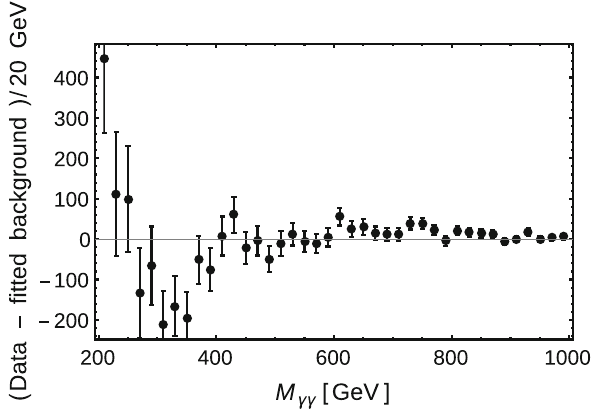
Fig. 6 Thedifferencebetweenthebinnedeventswithselectioncriteria C 2 and their smooth fit by the ATLAS fitting function [Eq. (5)] for the combined gg → γγ + qX → γγ